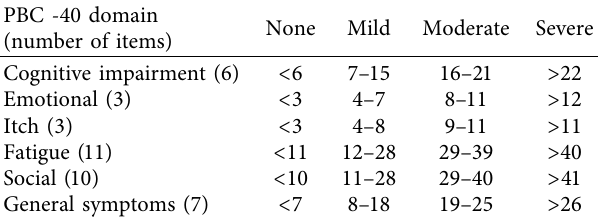
Table 1: Defned scores ranges and cut-ofs for PBC-40 domains. PBC -40